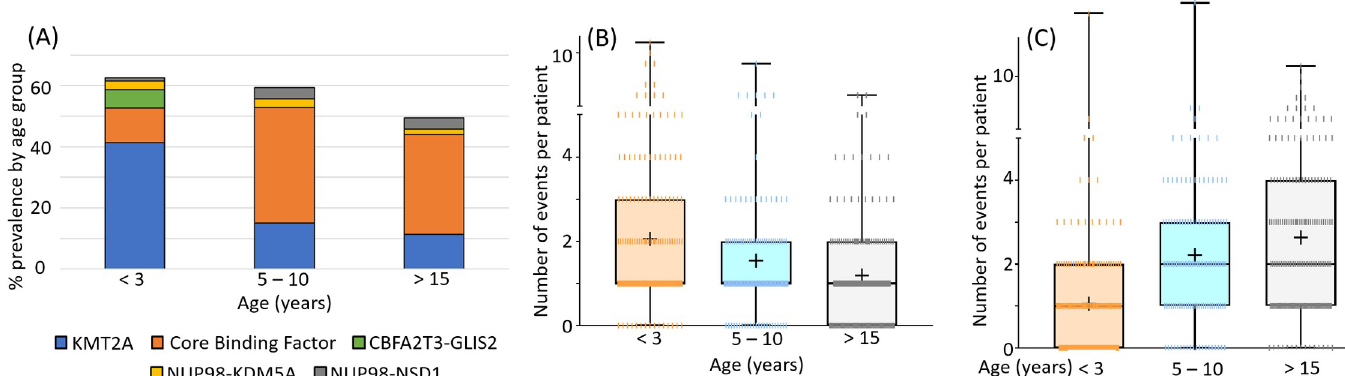
Fig 1. Infant AML is genomically distinct from other pediatric AML. Shown are three distinctive characteristics of infant AML in a total of 510 pediatric AML patients ( < 3 years, n = 184; 5 to 10 years, n = 140; > 15 years, n = 186) from the CCG-2961, AAML03P1, and AAML0531 COG studies. ( A ) Infant AML is highly enriched in KMT2A ( MLL ) fusions, but has lower rates of Core Binding Factor (t(8;21) and inv(16) or t(16;16)) translocations. Certain fusions, such as CBFA2T3 : GLIS2 fusions appear exclusively in this age group. ( B ) Karyotypic events (translocations, and whole-chromosome and chromosome-arm level copy number alterations) are more prevalent in infant AML, with an average of 2.1, 1.5, and 1.2 events per patient for < 3, 5 to 10, and > 15 year old age groups, respectively; p = 0.0144 ( < 3 vs. 5 to 10) and p = < 0.0001 ( < 3 vs. > 15). ( C ) In contrast to structural/karyotypic alterations, infant AML is accompanied by few single nucleotide alterations and small insertions/ deletions (indels), with averages of 1.1, 2.2, and 2.6 mutations per patient for the above described age groups, respectively; p = < 0.0001 for each comparison of < 3 versus other age